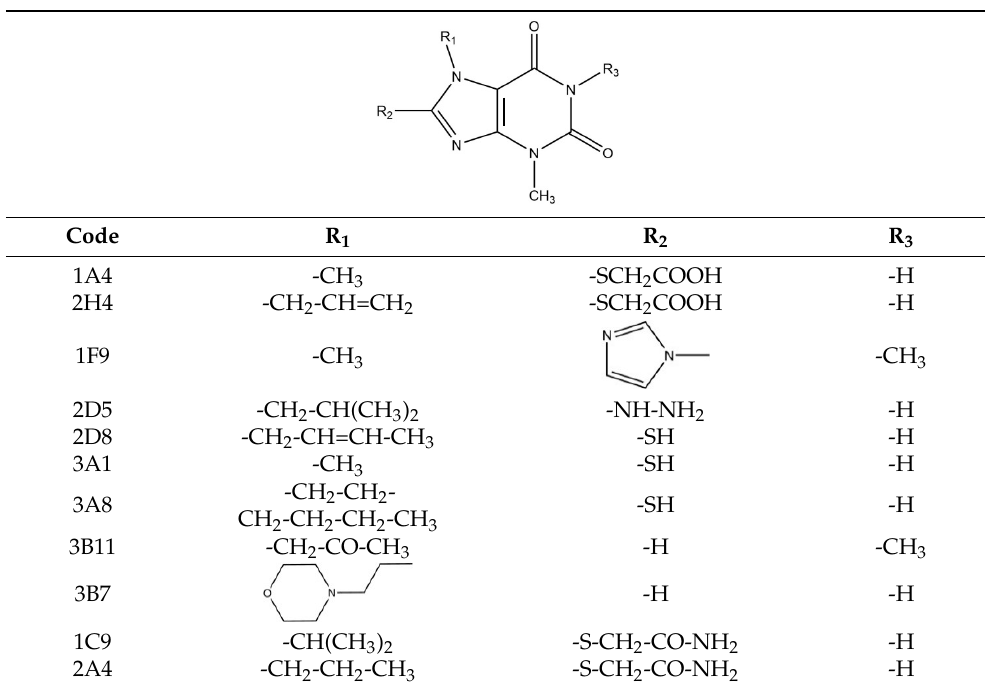
Figure 1. Reference NMR spectra of fragments and STD NMR spectrum. The spectra from #1 to #8 were the individual spectrum of fragment in a single NMR tube, respectively. STD NMR spectrum showed that compound #3 might bind to JNK3 (indicated by red arrow).